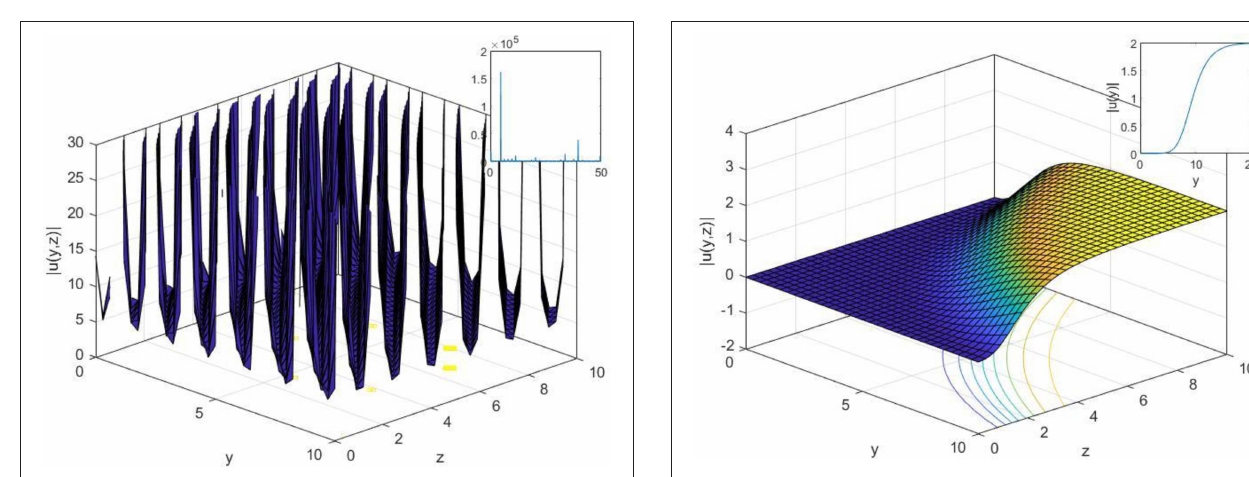
FIGURE 5 | 2-D, 3-D, and contour plot of periodic singular soliton solution Equation (24) when λ 0.1, µ 0.3, β 0.6, α 0.9, ε 0.1, c 0.3, t = = = = = = = 2, γ 0.3, a 0 0.5, b 1 0.2 and z 2 for 2-D. = = = =